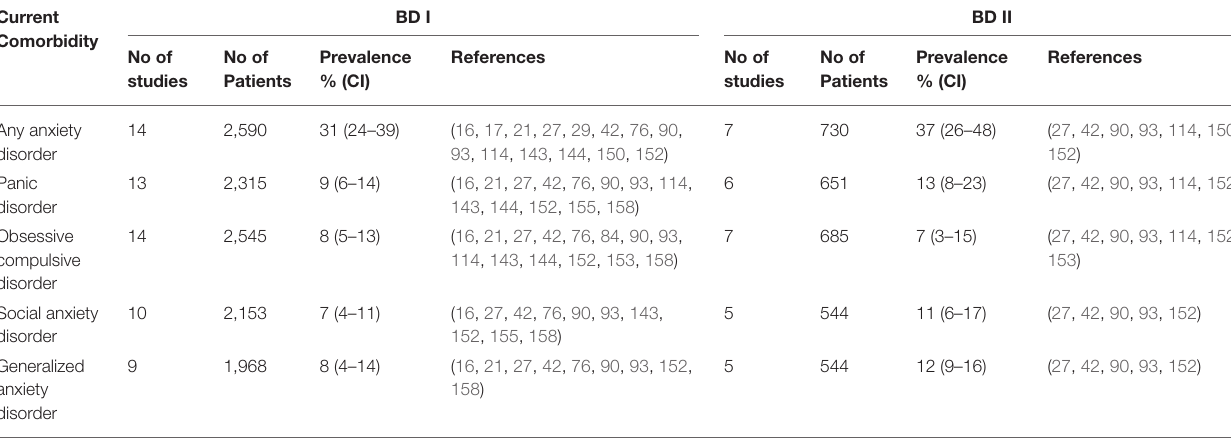
TABLE 4 | Current comorbidity of anxiety disorders in bipolar disorder I and bipolar disorder II. Current